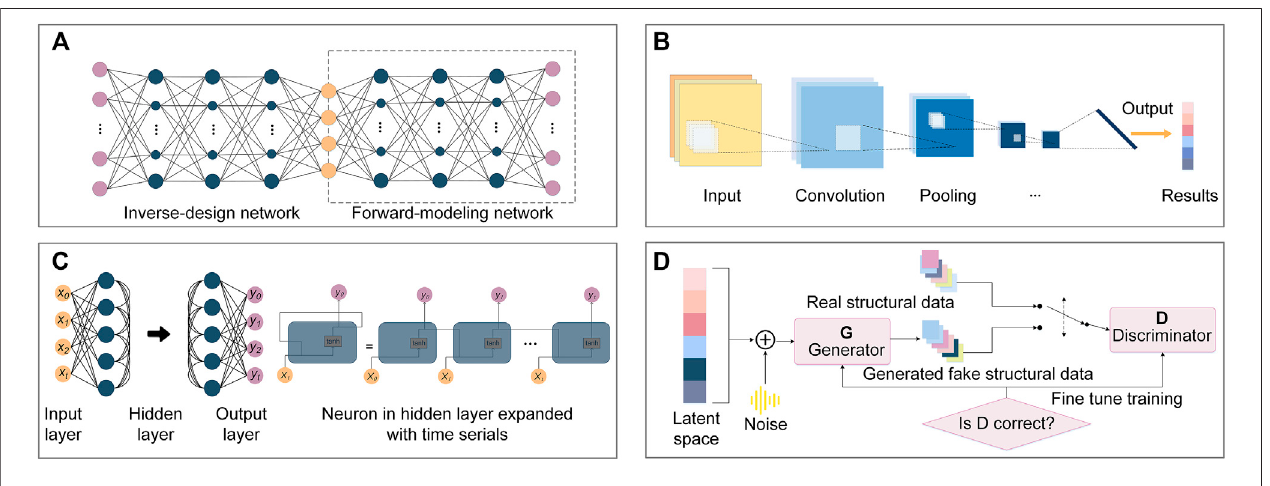
FIGURE 2 | Schematic illustration of typical deep learning models. (A) Multilayer perceptron, (B) Convolutional neural networks, (C) Recurrent neural networks, (D) Generative adversarial network.